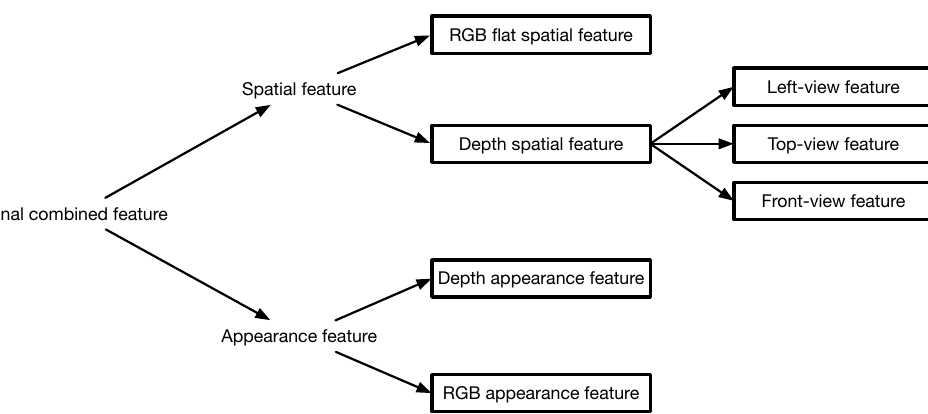
Figure 4. An overview of the final combined feature of a pair of detected objects. The final visual feature vector is composed of four parts: S RGB , S Depth , A Depth , A RGB . The spatial feature is extracted by the second module of the proposed multi-view VRD framework, and the appearance feature is generated by the object detector. Note that the depth spatial feature S Depth is composed of S DepthL , S DepthT and S DepthF